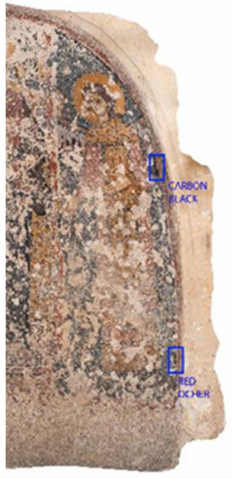
Figure 3. Sample areas of pH, efficacy, and colorimetric